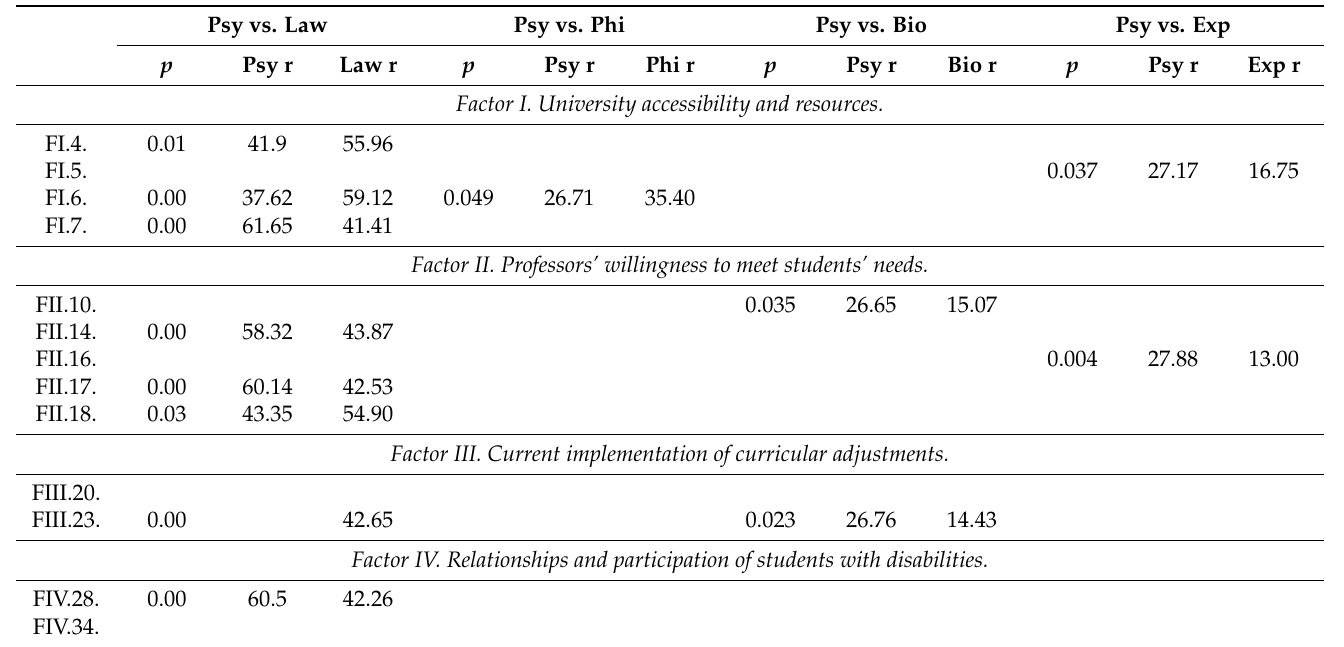
Table 14. Post hoc Kruskal–Wallis analysis analysis according to the teaching area (Psycology vs. others).